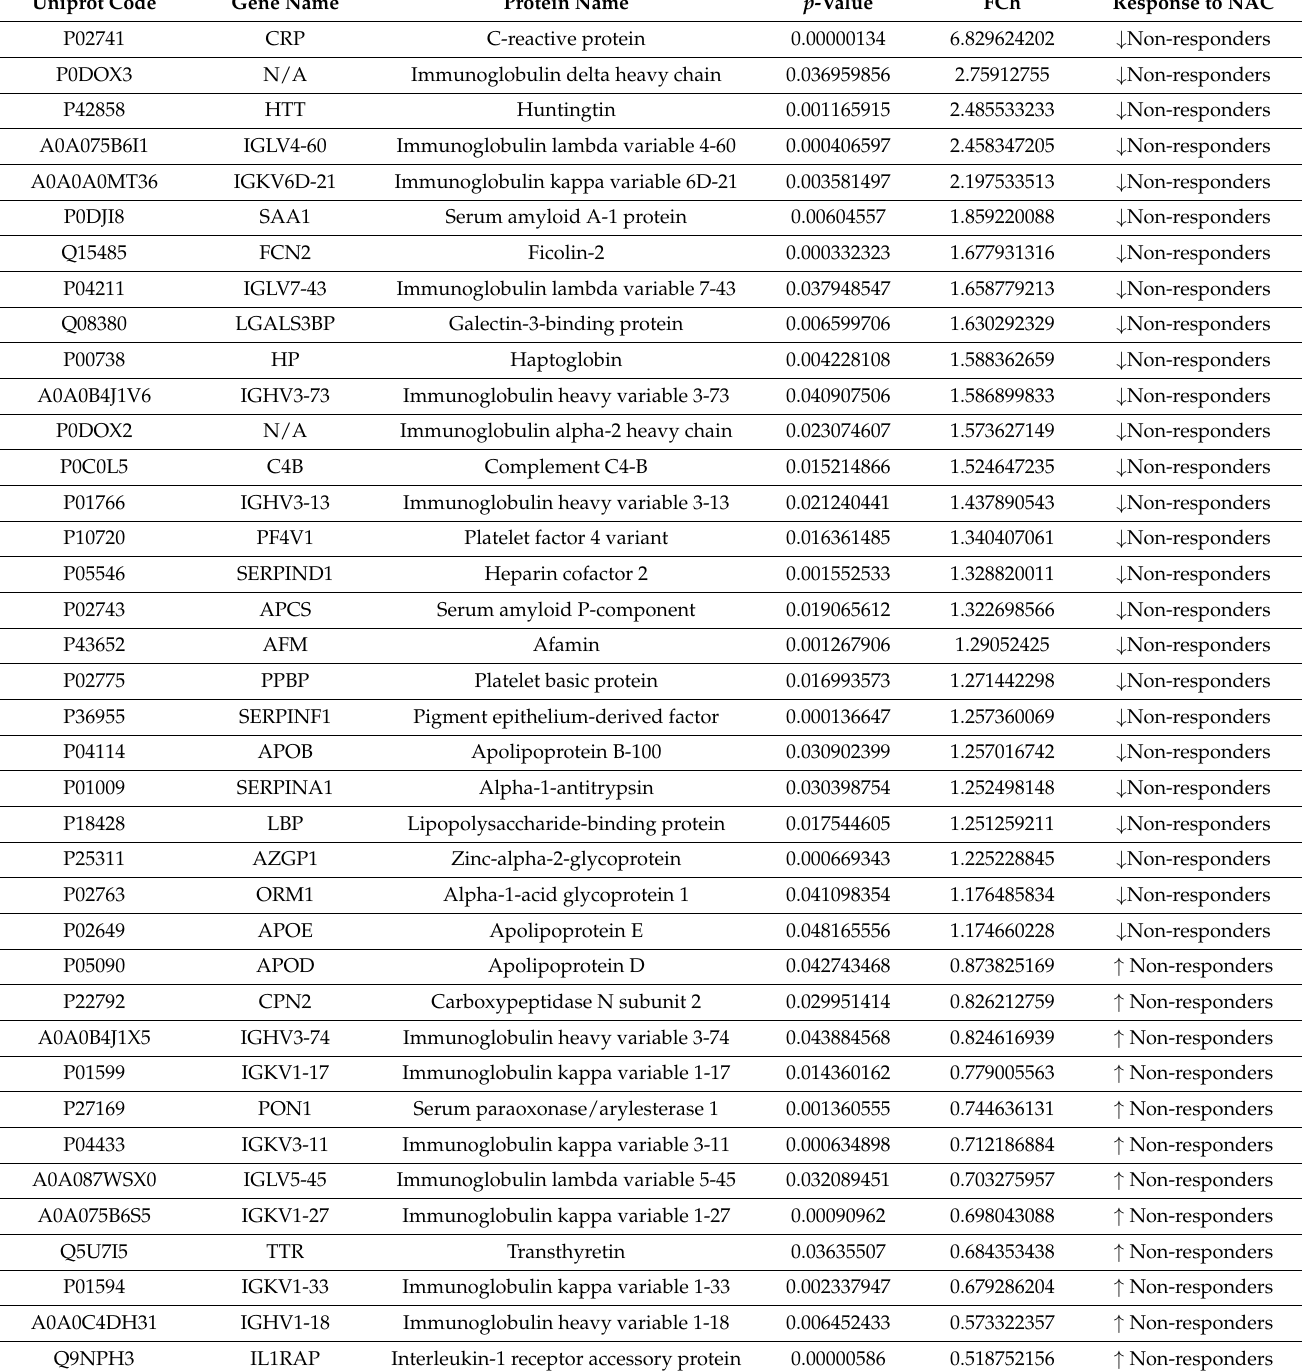
Table 4. Specific differentially expressed proteins detected in non-responder patients relative to the responders’ group after the analysis of serum samples ( method 1 ) by SWATH-MS. The fold change ratio (FCh) was calculated as the ratio of the geometric mean of the samples, corresponding to the calculation of the normal arithmetic ratio of the logarithmic transformation and inverse transformation regions ( ↓ denoted downregulation, ↑ denoted